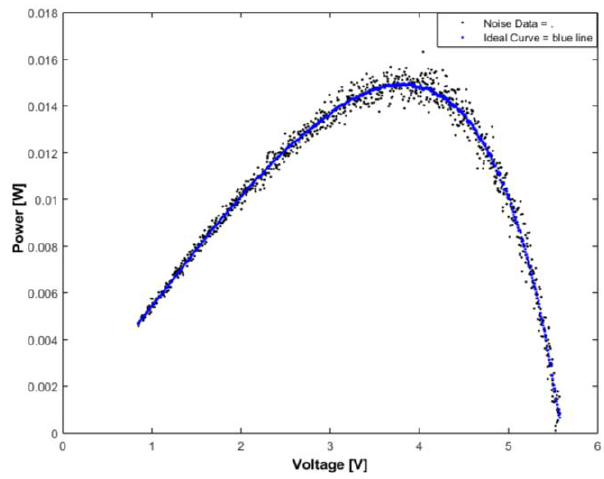
Figure 7 . I-V curve with noise measured data.